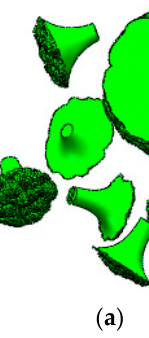
Figure 5. Simplified modeling of simulation objects: ( a ) blocks; ( b ) cylindrical bar and stoppers.